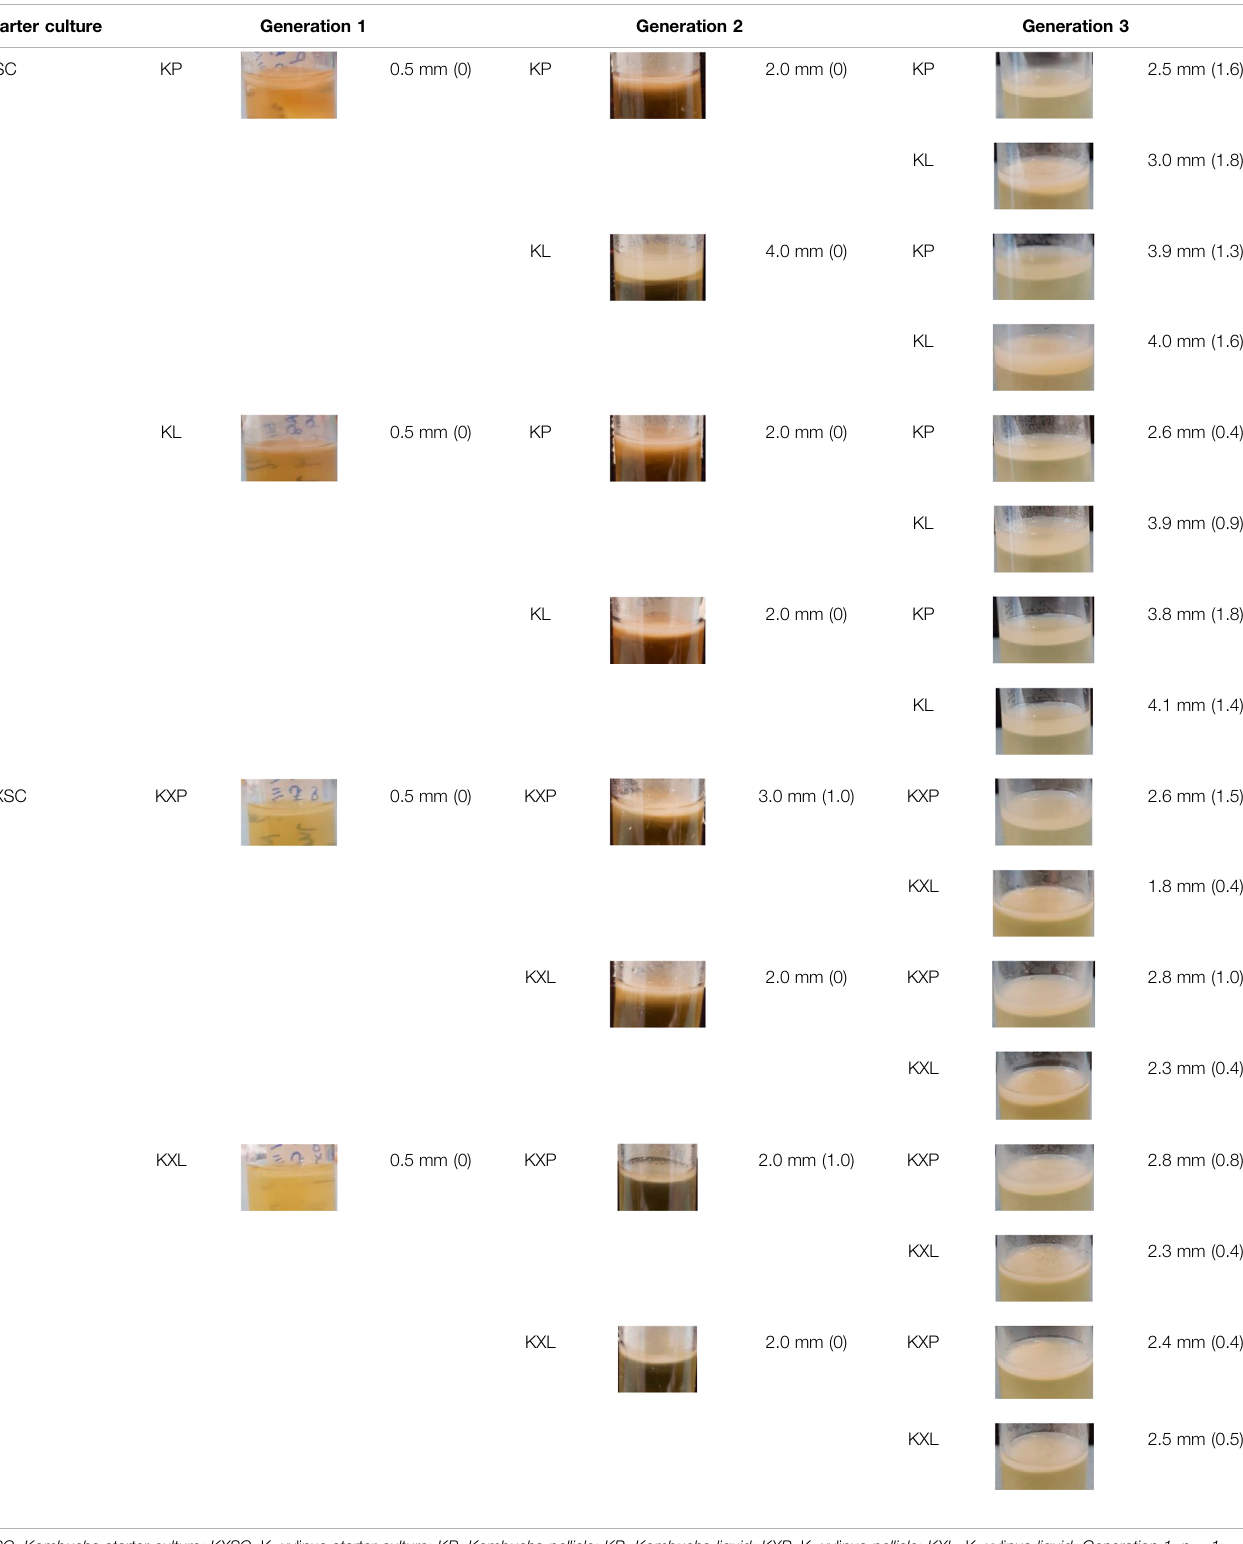
TABLE 1 | Observed mean thickness of